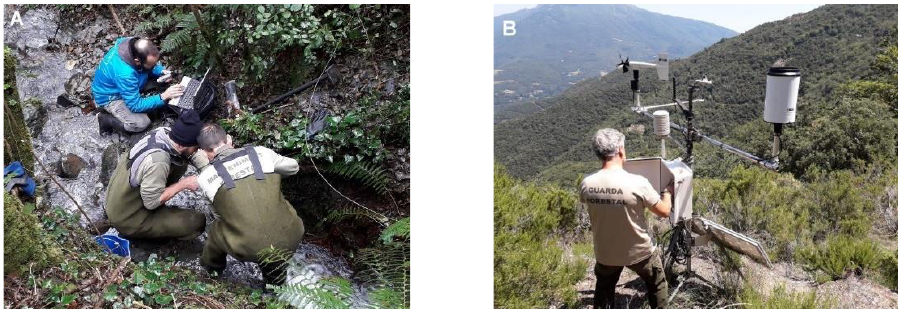
Figure 4. Network of monitoring abiotic variables. ( A ) Technicians downloading hydrological data. ( B ) Meteorological station located in eastern subpopulation area.